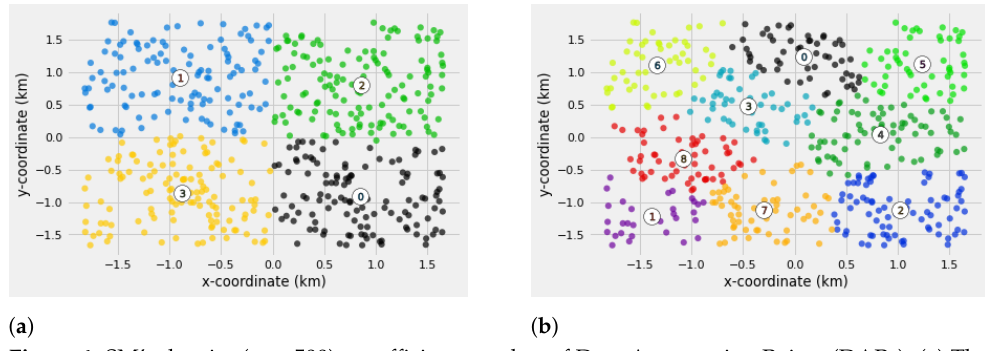
Figure 4. SM’s density ( n = 500) vs. efficient number of Data Aggregation Points (DAPs): ( a ) The determined structure for n = 500, when K = 4; ( b ) The determined structure for n = 500, when K = 9. However, the results of this will be validated through the silhouette analysis method.